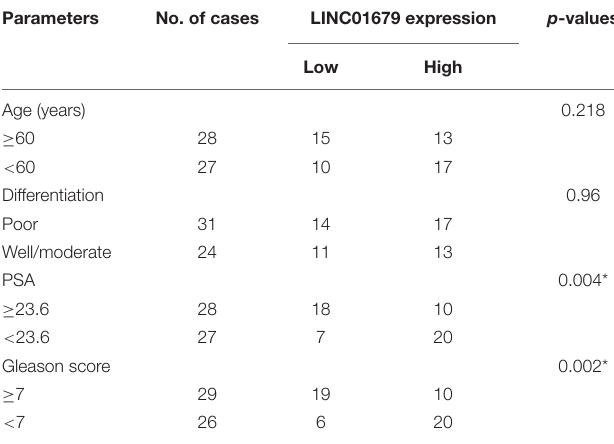
TABLE 1 | The Relationship between LINC01679 and clinicopathological characteristics in 55 patients with prostate cancer.